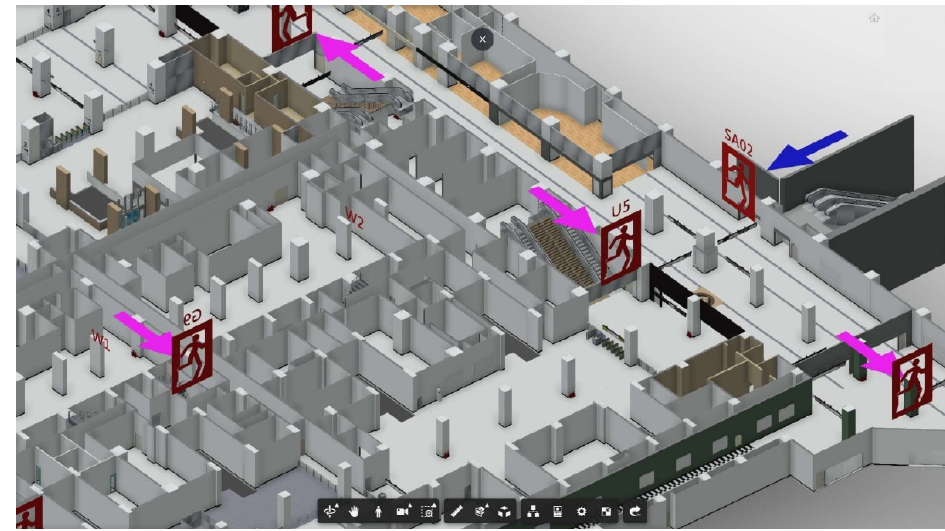
Figure 16. One-click trigger used to identify the nearest exit. (Source: Research Data).